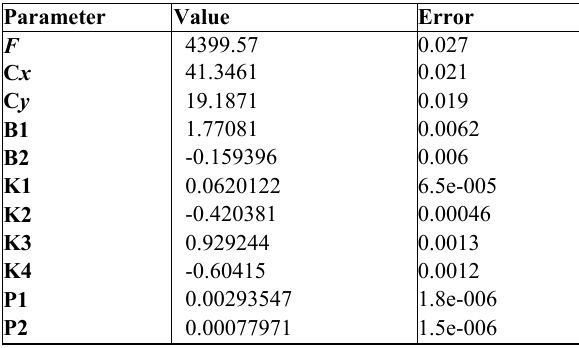
Table 2. Interior orientation parameters of the used S.O.D.A. sensor as calculated through the self-calibration method.